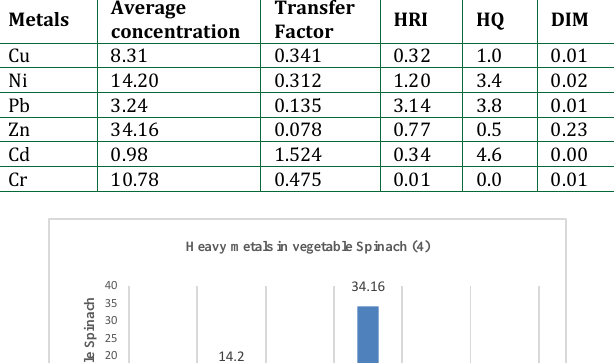
Table 14: Heavy metal Concentration in Vegetable Spinach (4).